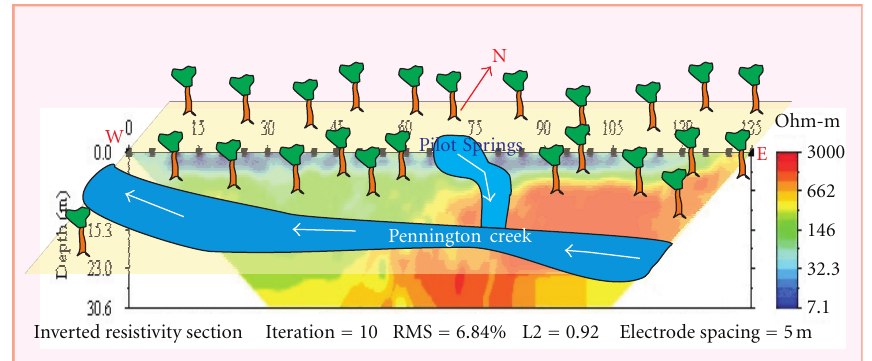
Figure 5: Location of Pilot Springs and Pennington Creek with respect to ERT profile CD. The orientation of the profile is W-E. Arrow marks shown in Pennington Creek and Pilot Springs indicate the direction of water flow.